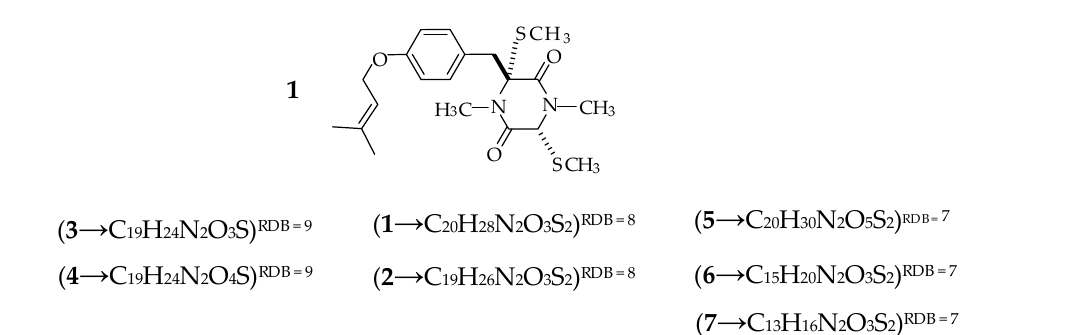
Figure 3. Comparison of cis- bis(methylthio)silvatin ( 1 ) and metabolites 2–7 for structural assignment.